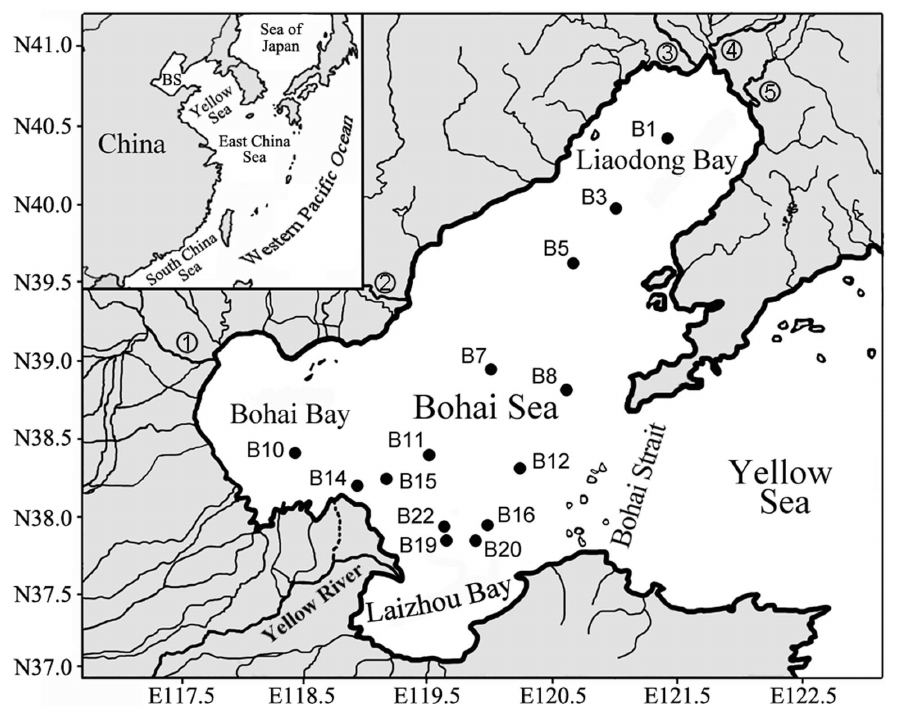
Figure 1. Map of the Bohai Sea and the sites of sampling stations. The insert map shows the geographical location of the Bohai Sea in the western Pacific Ocean. Abbreviation and numerical symbols: BS, Bohai Sea; 1, Haihe River; 2, Luanhe River; 3, Dalinghe River; 4, Liaohe River; and 5, Daliaohe River.